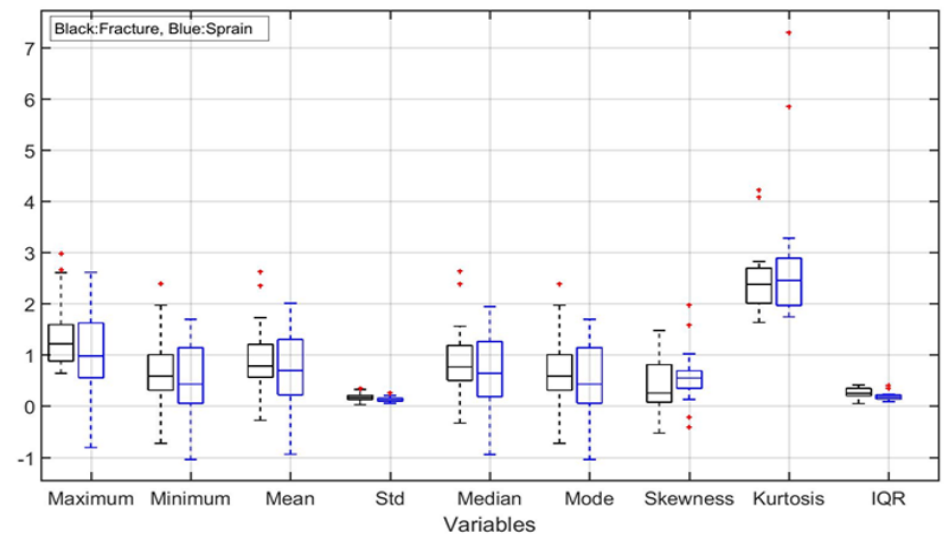
Figure 7. Boxplots of average differences between the injured and uninjured contralateral wrists for the statistical measures. Note: the label for vertical axis is not shown, as the variables do not have the same unit. The unit for minimum, maximum, mean, standard deviation (std) and interquartile range (IQR) is °C. Skewness and kurtosis have no units. To select the statistical measures that provided greater differentiation between frac- ture and sprain, the following operations were performed. The mean values of the statis- tical measures for the sprained wrists were obtained. These values were compared with